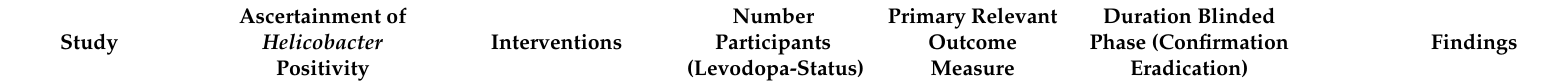
Table 1. Randomised controlled trials of e ff ect of H. pylori eradication on severity of, and hypokinesia in, idiopathic